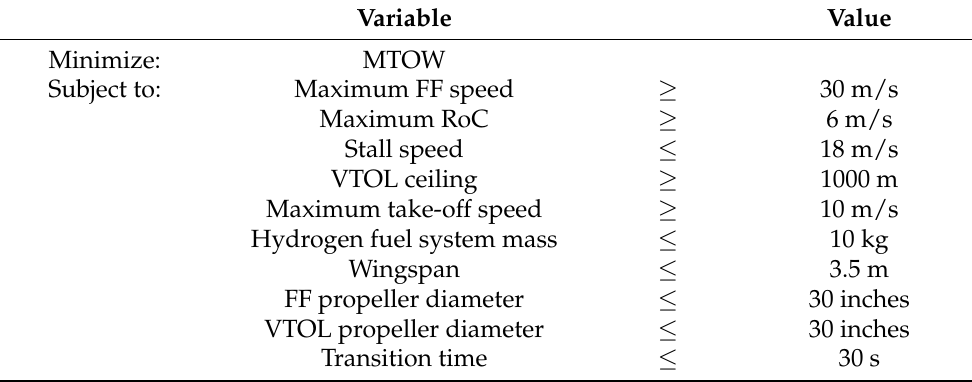
Table 7. Example of sizing optimization